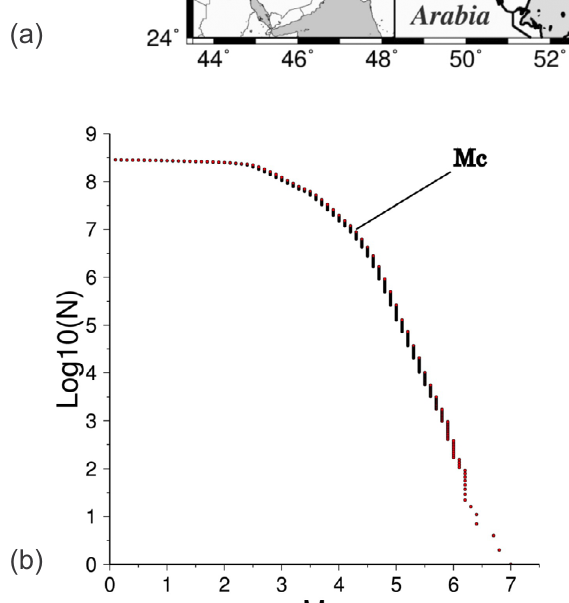
Figure 1. (a) Fault map of Iran with the epicentral distribution of 436 earthquakes investigated in this study. Faults were adopted from the active fault map of Iran [Hessami et al. 2003]. (b) M nation for our